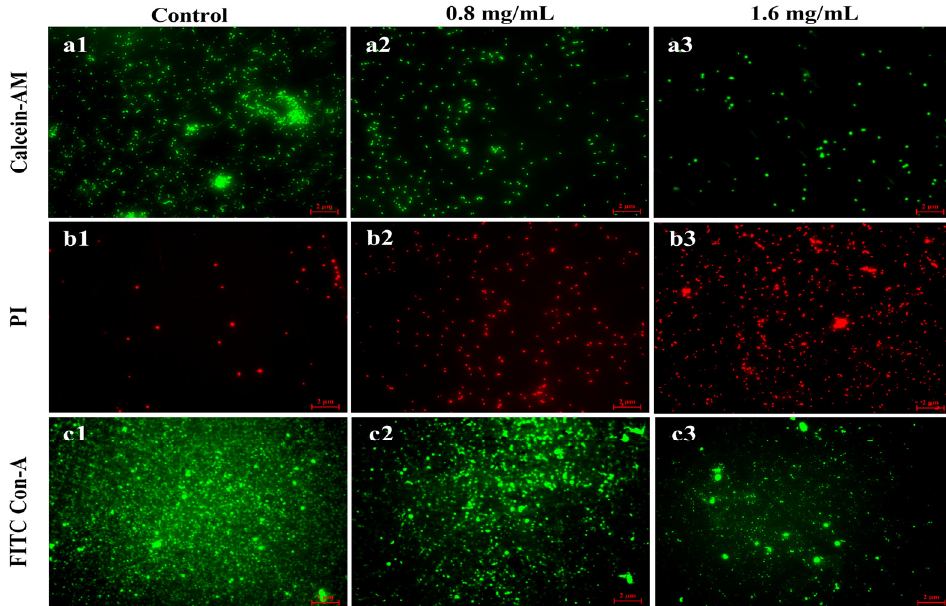
Figure 6. The effects of Z057-E on cells and EPS in V. parahaemolyticus biofilms as observed by fluorescence microscope. ( a1 , b1 ) exhibited the cell distribution of untreated biofilms, and green or red fluorescence, indicating that the cells were alive or dead. ( a2 , b2 ) represented the distribution of live and dead cells in biofilms treated with 0.8 mg/mL of Z057-E. ( a3 , b3 ) showed the distribution of live and dead cells in biofilms treated with 1.6 mg/mL of Z057-E. ( c1 – c3 ) displayed the distribution of EPS (green fluorescence) in biofilms treated with 0, 0.8, and 1.6 mg/mL of Z057-E, respectively.